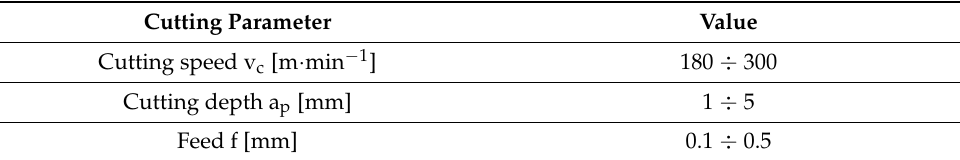
Table 3. Recommended cutting parameters used for the selected tool [46].